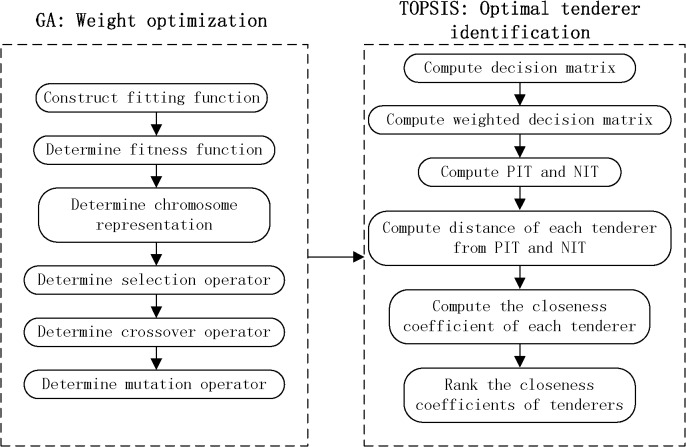
Detailed procedure of the proposed approach.